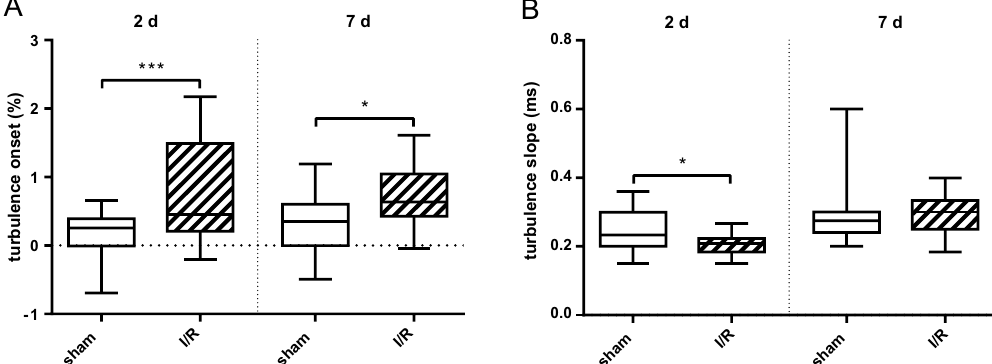
Figure 5. Baroreflex sensitivity is reduced after I/R. ( A ) Turbulence onset increases both at 2 days and 7 days after I/R as indicated (*** p < 0.001 and * p = 0.046, respectively). ( B ) Turbulence slope is depressed at 2 days after I/R (* p = 0.034). The heart rate variability parameters turbulence onset and slope are surrogate markers for baroreflex sensitivity (see “Methods” section). Note that the results indicate a disturbed vagal nerve activity after I/R. Data are given as box and whiskers min to max (n = 6). Statistical significance of differences between I/R and sham control was assessed by a two-way ANOVA (Tukey’s multiple